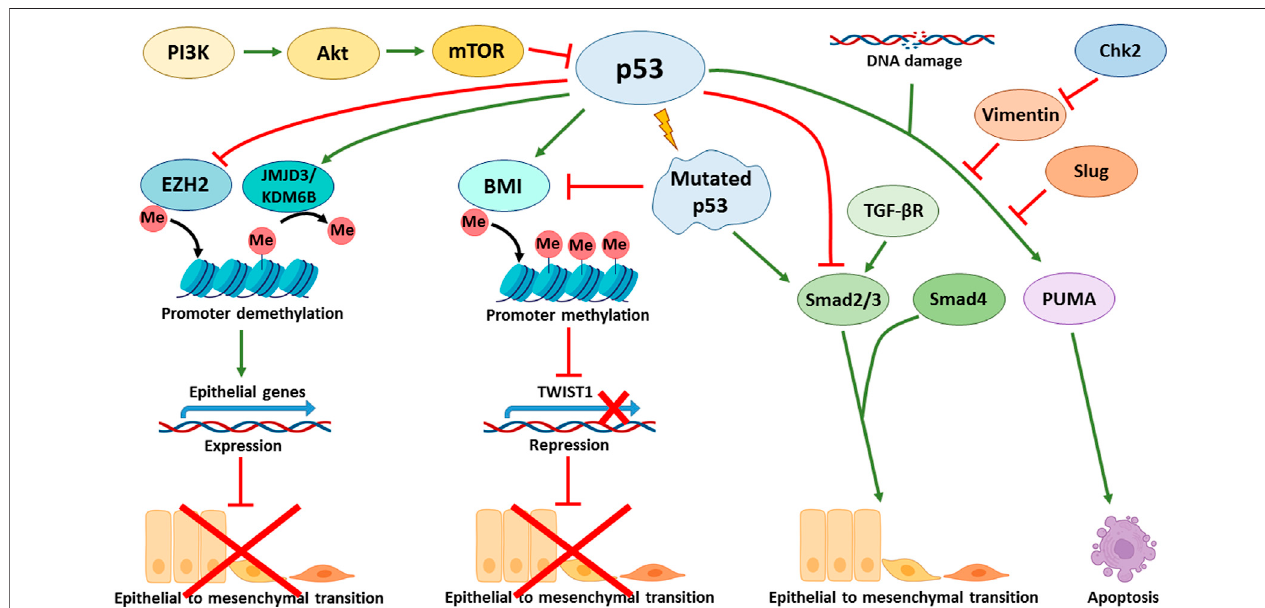
FIGURE 3 | p53 affects various signalling pathways involved in the regulation of EMT. p53 directly activates the transcription of CDH1 (E-cadherin coding gene) by bindingtoitsenhancerpromotingepithelialphenotype.Additionally,p53activatestheexpressionofE-cadherinattheepigeneticlevelthroughrecruitingJMJD3/KDM6B demethylase that removes repressive marks from histones and promotes the activation of p53 target genes. Furthermore, p53 negatively regulates EZH2 (Enhancer of Zeste Homolog 2) that represses E-cadherin. p53-mediated expression of BMI1 contributes to the maintenance of a repressive mark in the TWIST1 promoter region. Mutations inp53 leadtosuppression ofBMI1 and positive regulationofTWIST1. In addition, mutantp53activates EMTvia theTGF- β signallingcascade.Inturn, SlugandVimentininhibitthep53effects,e.g.,suppressingPUMA-dependentapoptosisinresponse toDNAdamage.Chk2kinaseisabletoblocktheeffect ofVimentin and support the p53 effects. PI3K/Akt/mTOR signalling axis negatively regulates p53, thereby contributing to EMT in p53wt